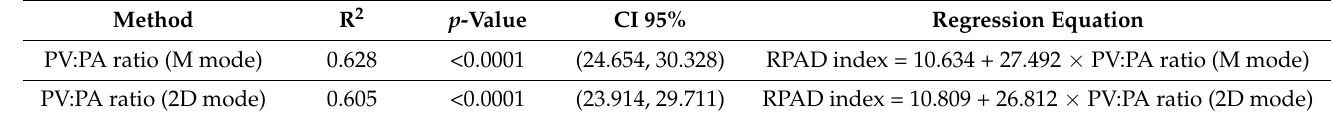
confidence interval 95%; p : Pearson correlations; PV:PA: pulmonary vein to pulmonary artery ratio;